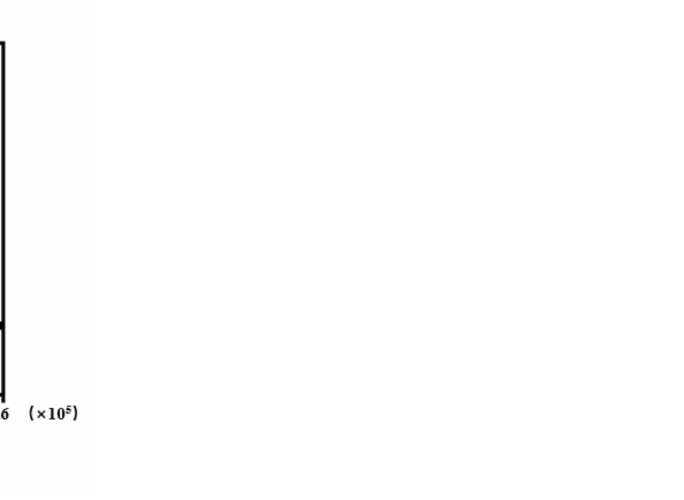
Figure 4. Each coating’s Nyquist pattern for immersion for 15 days: ( a ) 20% Seawater; ( b ) 40% Seawater; ( c ) 60% Seawater.